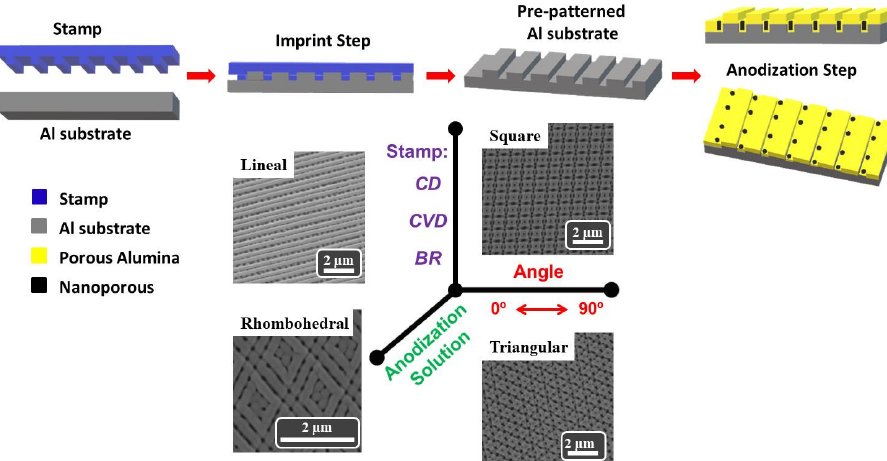
Figure 1. Schematic view summarizing the imprint and anodization processes to obtain the ordered porous nanostructured template. A general summary of the different parameters that can be used in the proposed fabrication process is shown at the bottom of the figure.